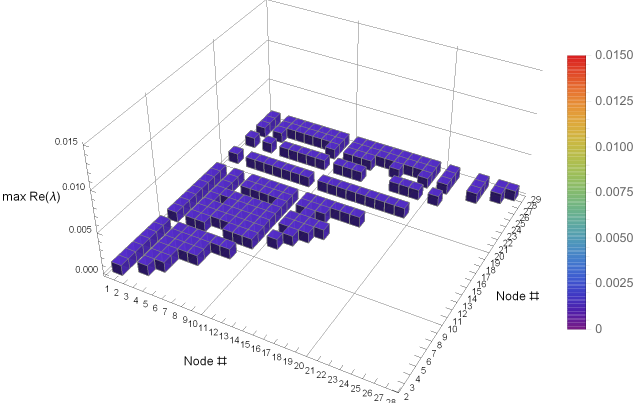
Figure 15. IEEE 39 bus: max ( Re ( λ )) for VSCs with vector control connected to different nodes.